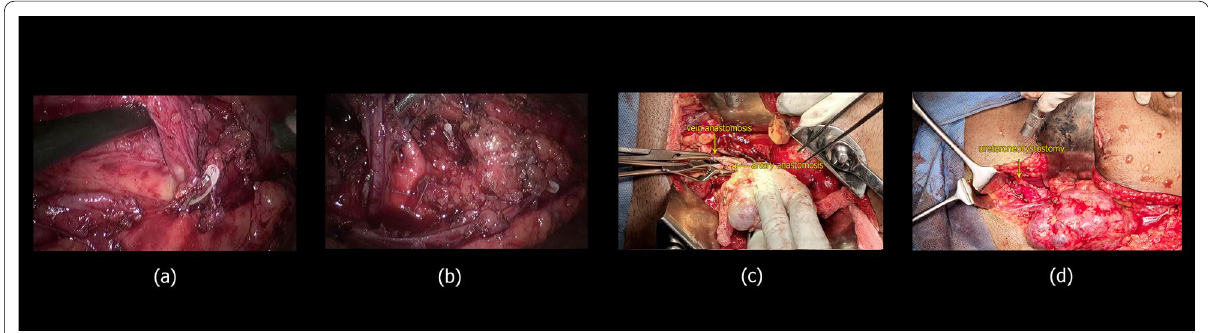
Fig. 3 a Dense left periureteral adhesions from the level of iliac vessel crossing. b Left single renal artery and vein dissected out. c After completion of vascular anastomosis during renal autotransplantation. d After completion of ureteroneocystostomy during renal